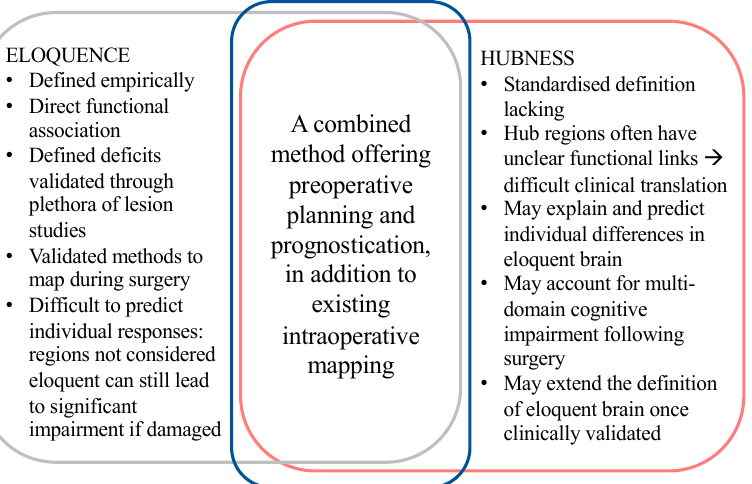
Figure 4. Comparing eloquence and hubness. Hubness may be used to extend the definition of eloquence once clinically validated. The intraoperative identification of eloquent brain can be combined with preoperative identification of hub nodes in each patient to further inform surgical decision-making.